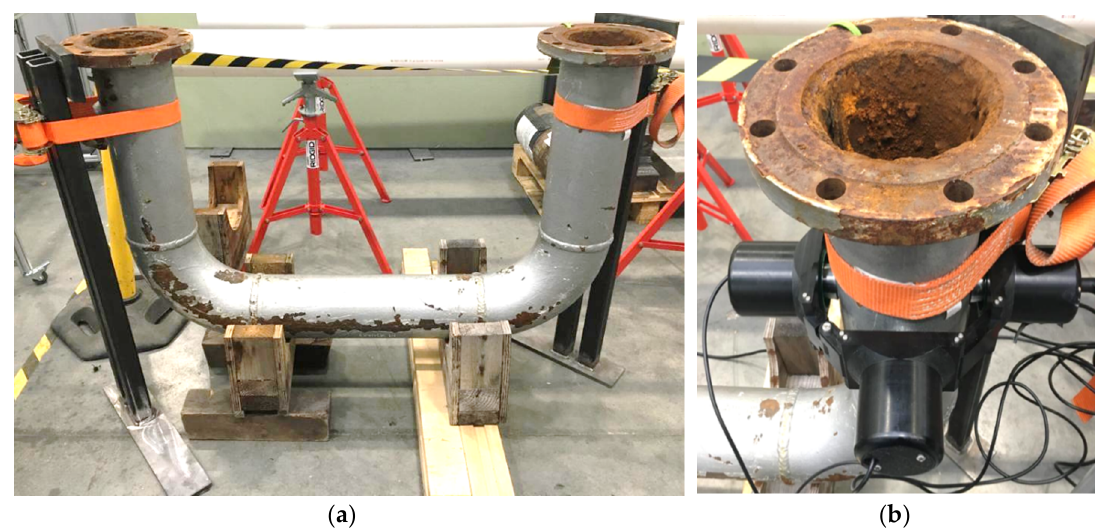
Figure 18. ( a ) U-shaped pipe set-up for fouling removal and ( b ) attachment of HPUT.